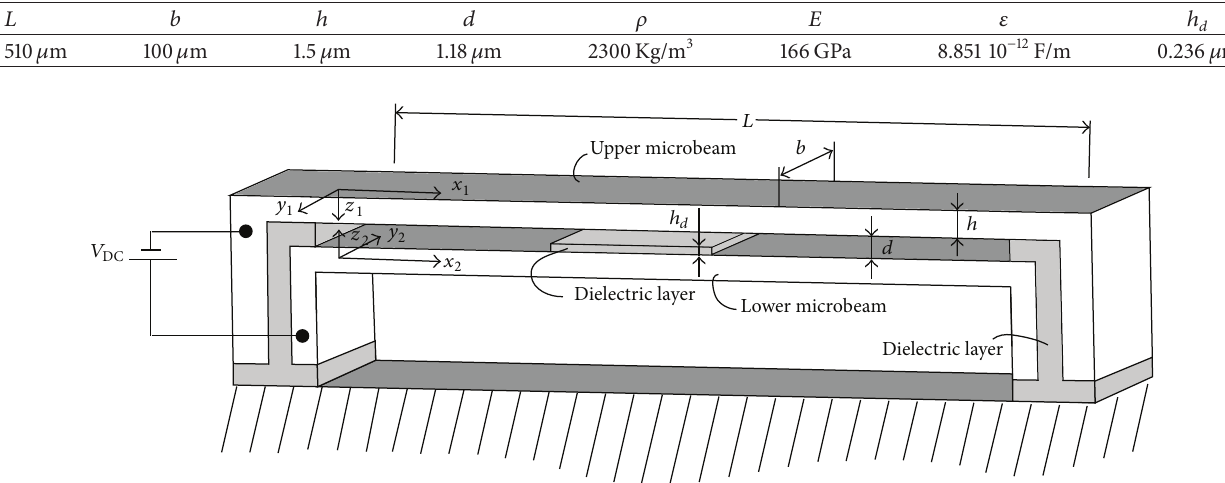
Figure 1: Capacitive contact RF-MEMS